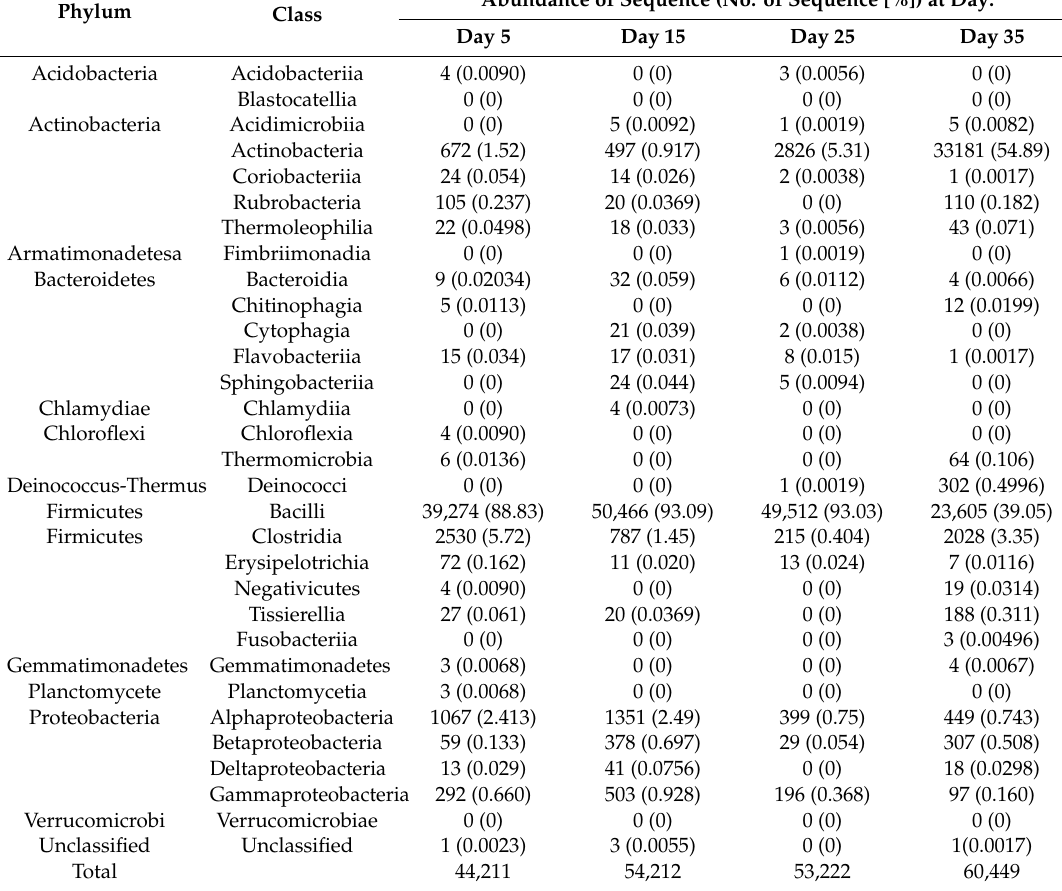
Table 2. Abundance of bacterial 16S rDNA sequences ( n = 212,094) identified from the jejunum microbiota of Cobb 500 broiler